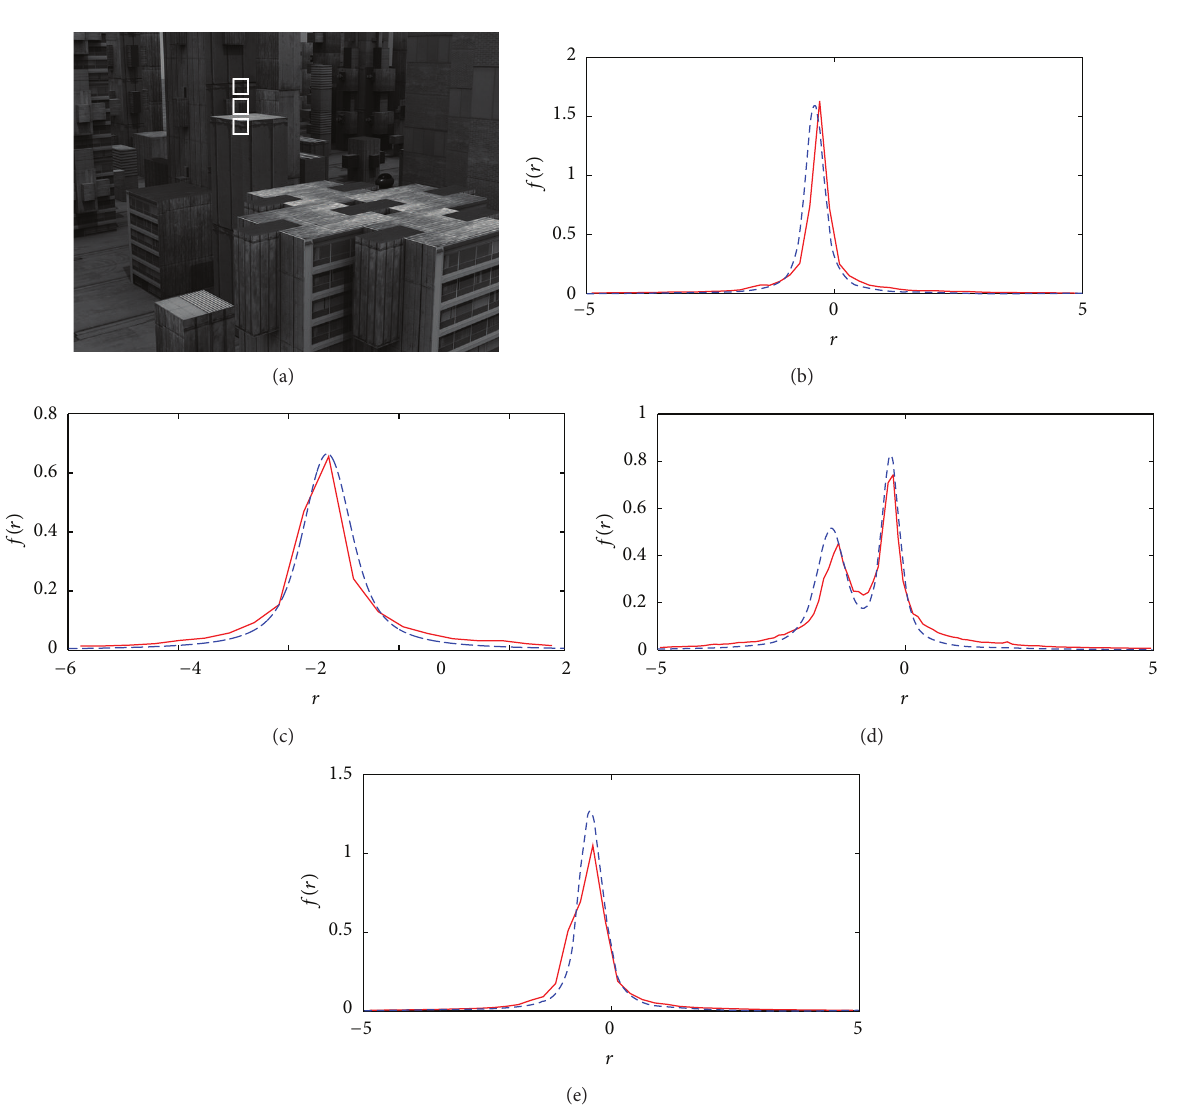
Figure 11: (a) A sample frame of the Urban2 image sequence. (b) and (c) Theoretical (dashed) and measured (solid) pdf of 𝑟 for two different patches on two different objects highlighted by white rectangles on the sample frame. (d) and (e) Joint pdf of 𝑟 values for two patches: (d) of two different objects and (e) of the same